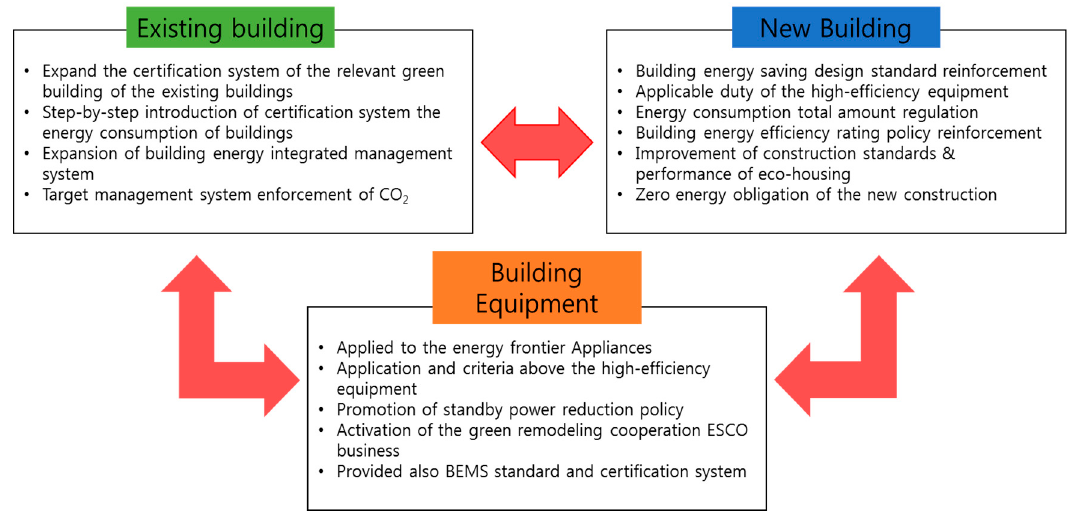
Figure 6. GHG reduction policies and energy reduction policy of building.